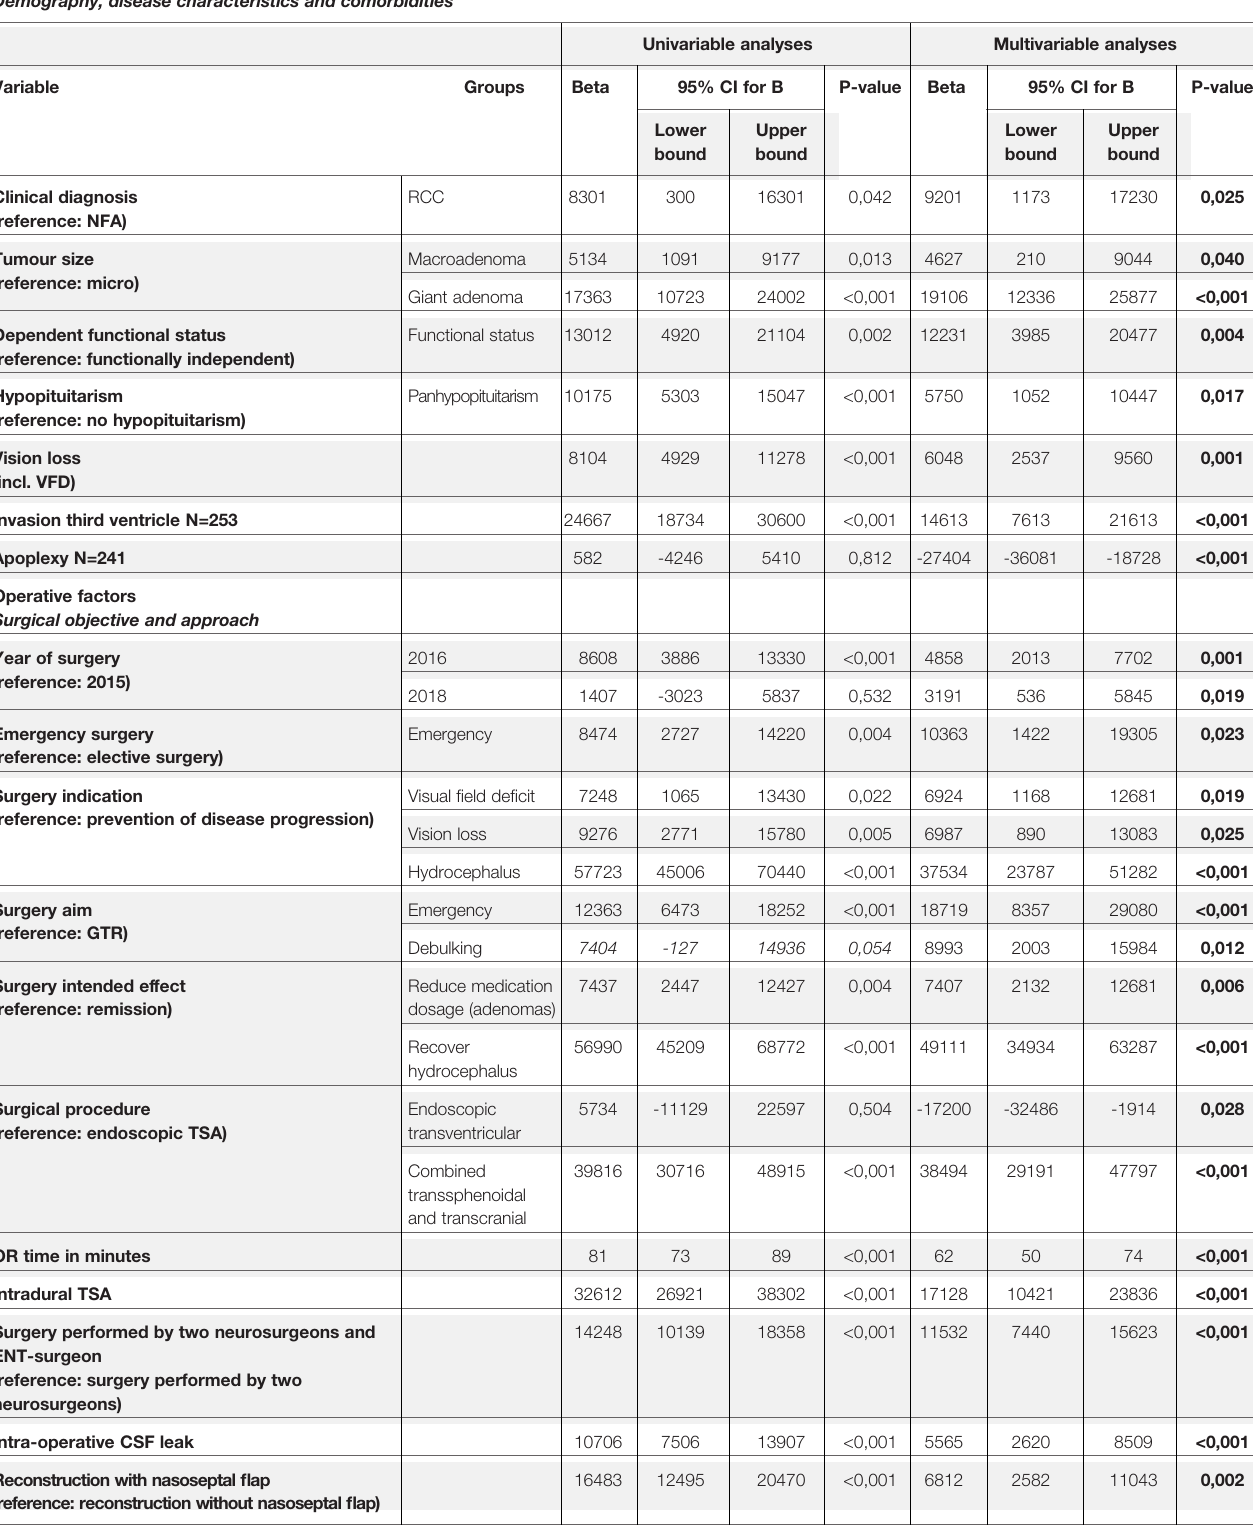
TABLE 2 | Univariable and multivariable linear regression analyses displaying signi fi cant determinants of total costs. Pre-operative factors Demography, disease characteristics and comorbidities